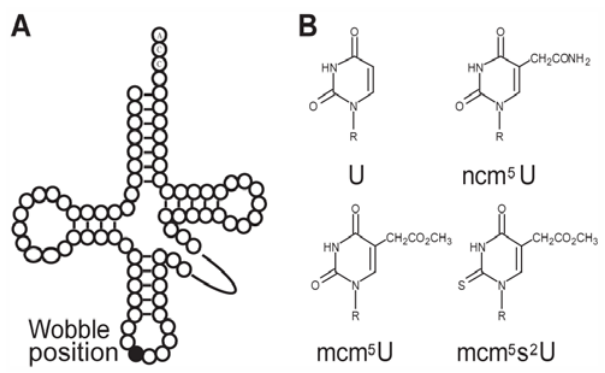
Figure 1. Schematic drawing of the tRNA secondary structure and modified wobble uridines. (A) Secondary structure of tRNA with wobble position shown ( N ). (B) Wobble uridines can be modified to 5-carbamoylmethyluridine (ncm 5 U), 5-methoxycarbonylmethyl (mcm 5 U) or 5-methoxycarbonylmethyl-2-thiouridine (mcm 5 s 2 U).